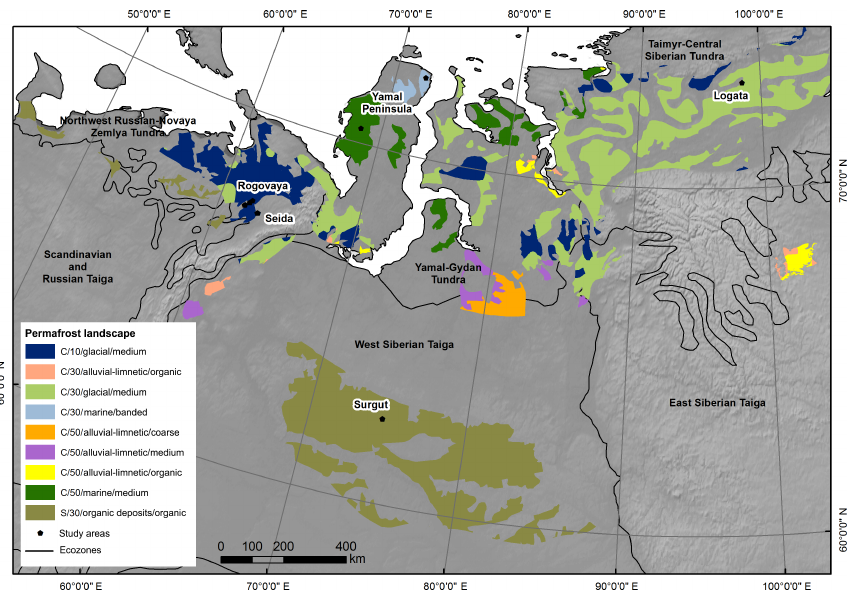
Figure D3. Study areas and associated permafrost landscapes in east Russia. Legend lists type of permafrost extent (C: continuous; D: dis- continuous; S: sporadic), ground ice content (vol%), surficial geology, and lithology. Shadowed labels name study areas with waterbody maps. Black lines and labels denote